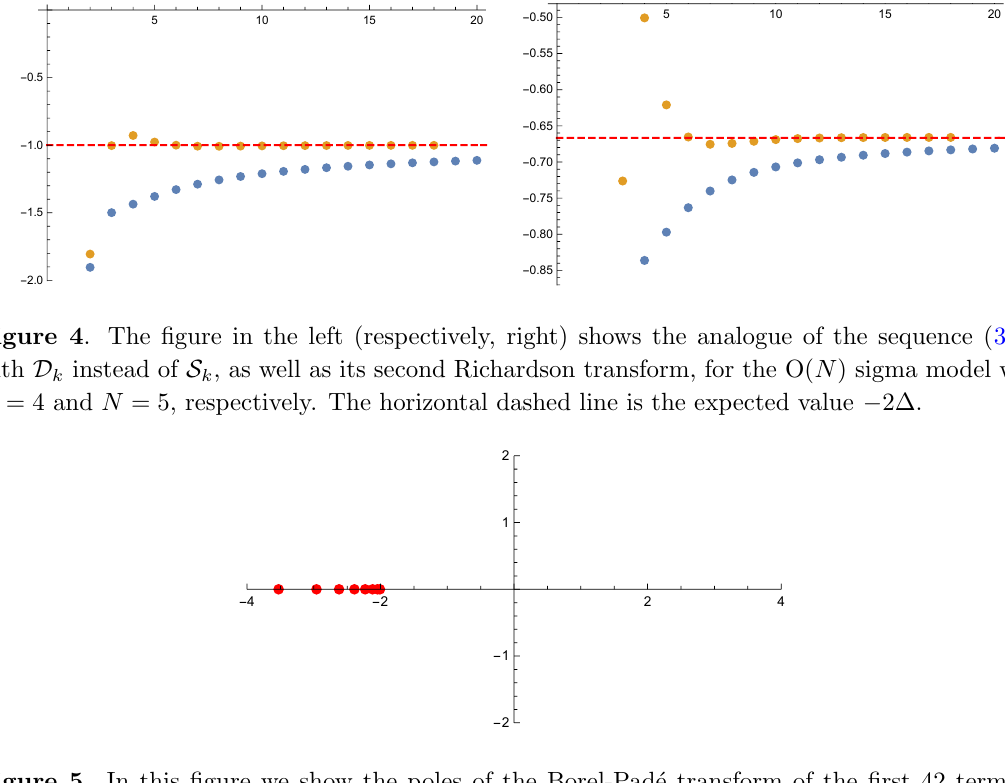
Figure 5 . In this (cid:12)gure we show the poles of the Borel-Pad(cid:19)e transform of the (cid:12)rst 42 terms of the perturbative series (2.82) for the supersymmetric O( N ) sigma model with N = 5. We consider the Pad(cid:19)e approximant (20 ; 20). The poles accumulate in one branch cut starting at the singularity (cid:16) = 2, corresponding to the (cid:12)rst UV renormalon. There is no IR renormalon singularity at (cid:16) = 2. (cid:0)